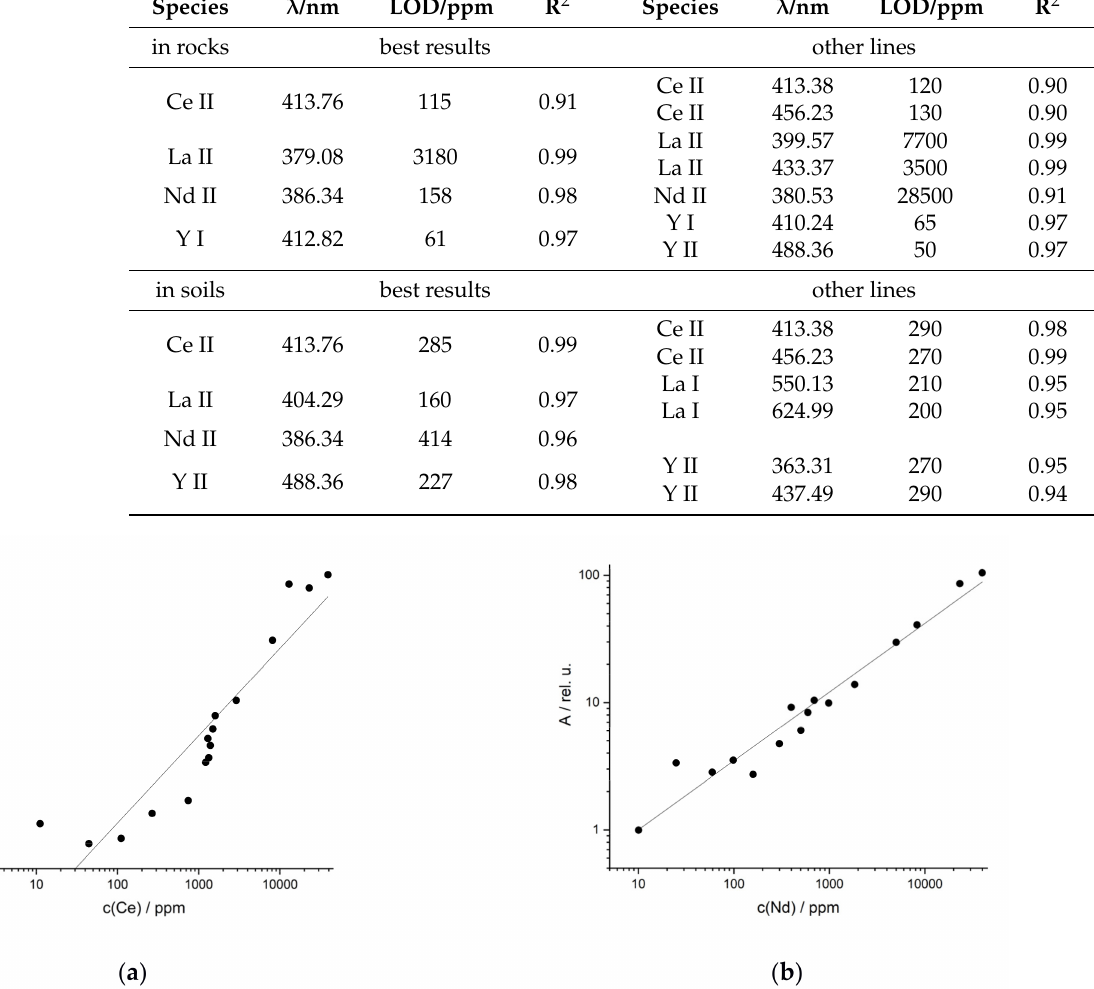
Figure 4. Univariate regression of synthetic samples in rock from ( a ) Ce (R 2 (413.76 nm) = 0.91) and ( b ) Nd (R 2 (386.34 nm) =